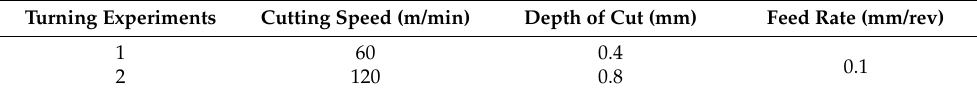
Table 3. The cutting regime in the experiments.